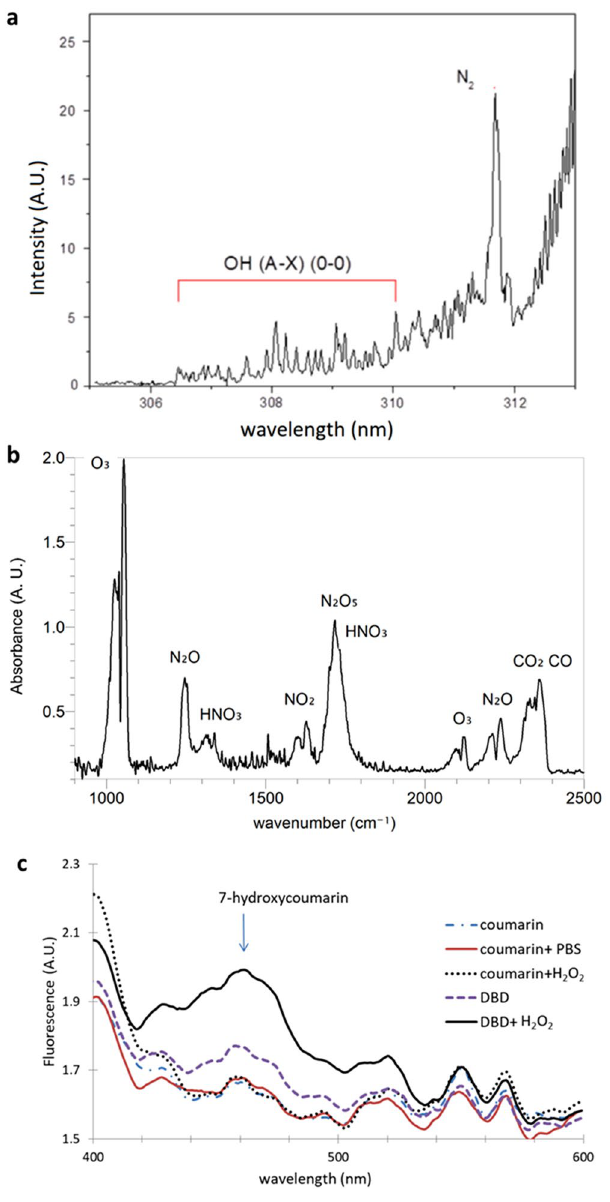
Figure 5. Spectral analysis of the flex-DBD: ( a ) Optical emission spectrum showing the OH · emission band. ( b ) Infrared absorption spectrum showing the long-lived active species, O 3 , NO 2 , N 2 O, etc. produced in the discharge. Spectrum taken after 1 min of operation at the power and voltage used for treating bacteria. ( c ) Fluorescence of the 7-hydroxycoumarin indicating the presence of OH · in solution. Solution of coumarin in PBS, and coumarin with H 2 O 2 are not different from the coumarin in water that is used to produce the baseline spectra. Fluorescence intensity increased at 460 nm following plasma treatment (DBD) and further increased for plasma treated H 2 O 2 solution (DBD + H 2 O 2 ). Spectra were taken immediately after treating 1.5 ml liquid samples for 5 min at the same DBD setting. Each curve is an average of three